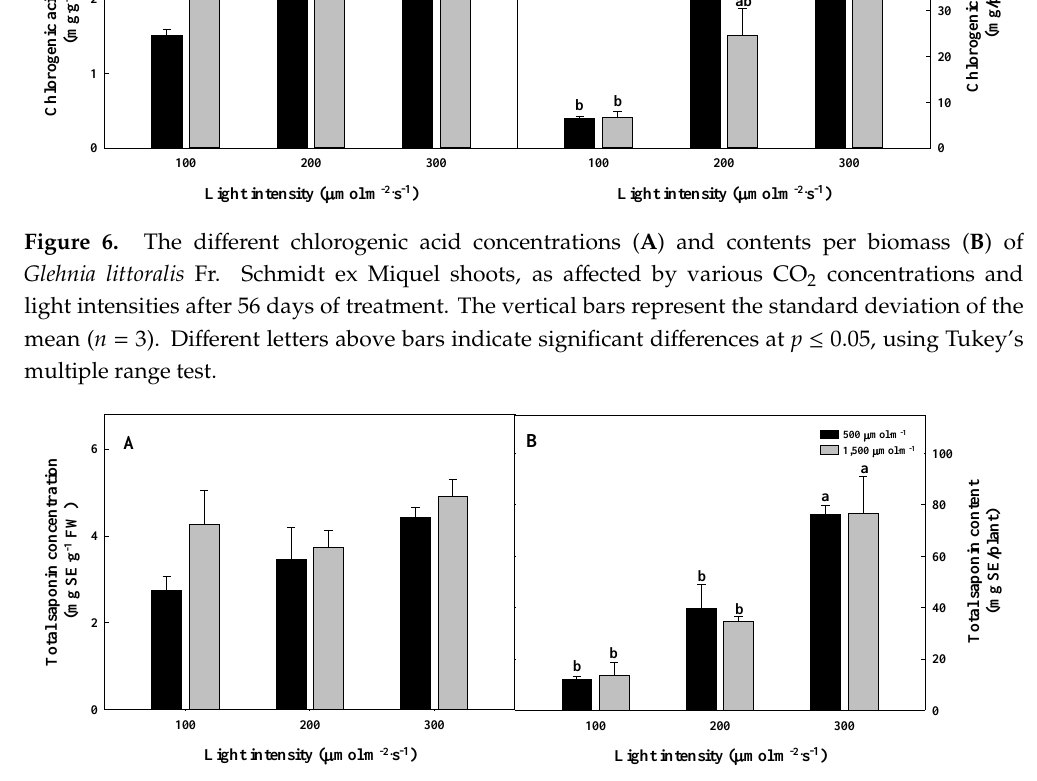
− 2 · − 1 s PPFD using RGB ◦ C, RH of 60 ± 10%, and a − 1 − 2 · − 1 s